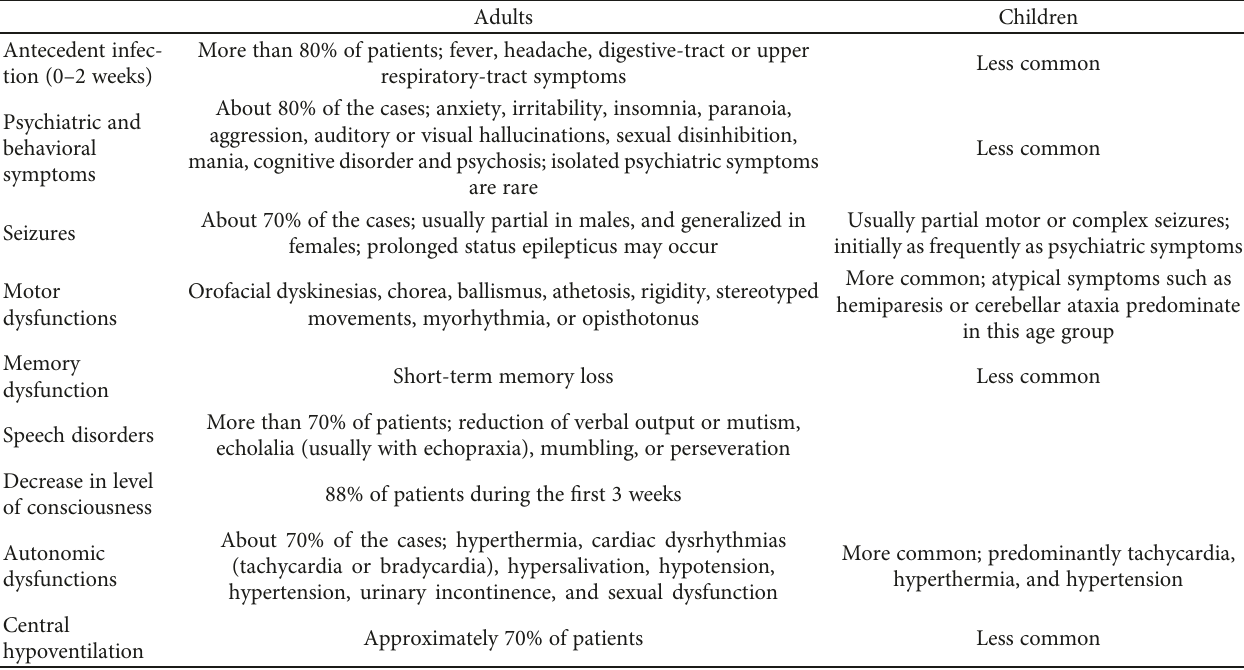
Table 1: Clinical features of anti-NMDAR encephalitis in adults and